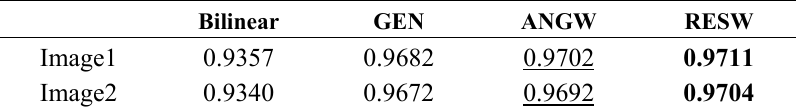
Table 4. SSIM comparisons of the reconstruction results in the simulation image data experiment.